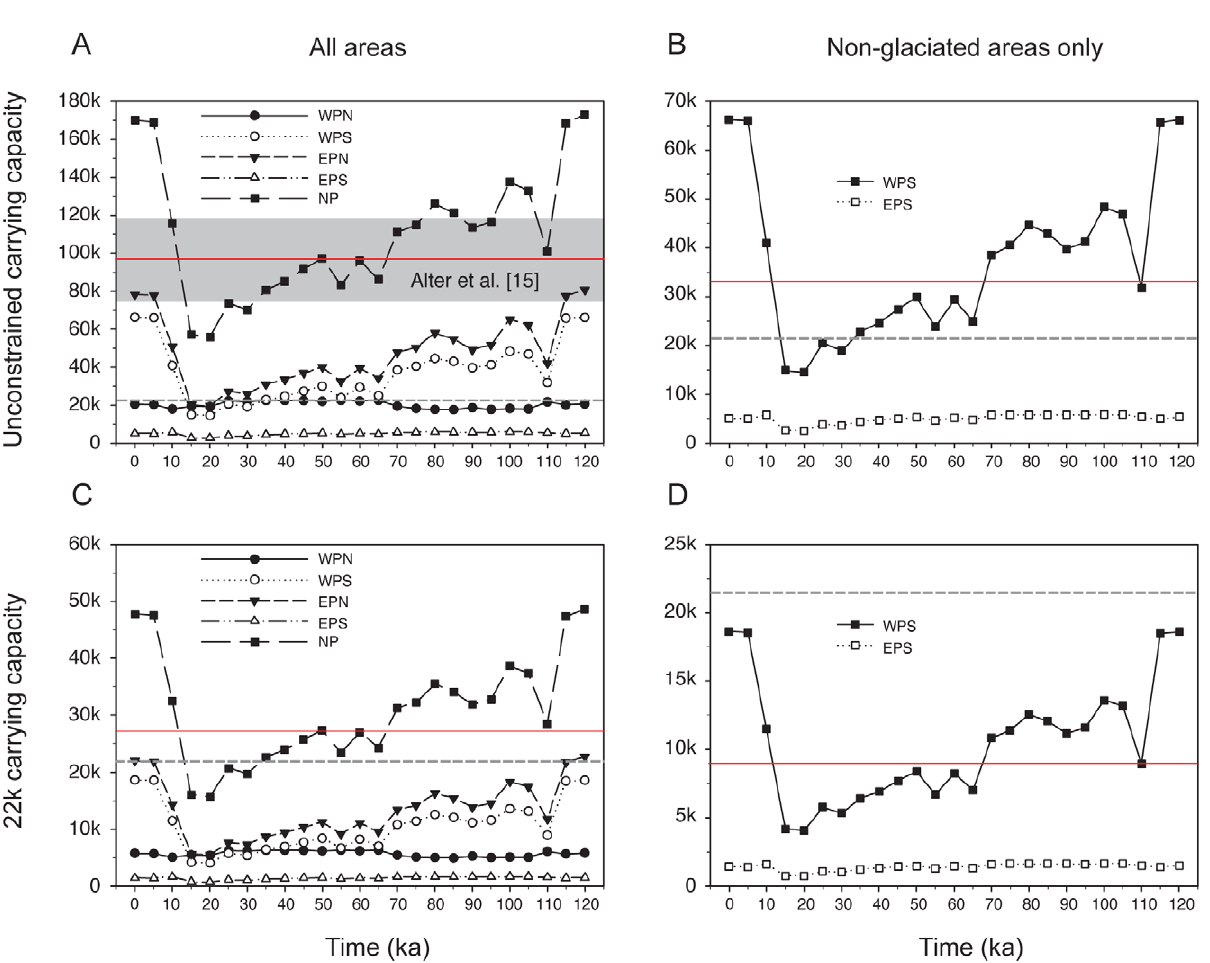
Figure 3. Estimated carrying capacity for North Pacific gray whales determined by benthos availability ( , 75 m) during the last 120 ka. Dashed gray lines indicate current gray whale population size and red lines show harmonic means for carrying capacity estimates. A) Total and regional North Pacific unconstrained carrying capacities. Gray box indicates range of population size suggested by analysis of genetic diversity [15]. B) Total and regional North Pacific carrying capacities constrained to 22 k gray whales; see Table 2; C) Unconstrained, estimated carrying capacities of non-glaciated regions in the western and eastern Pacific; D) Estimated carry capacities of non-glaciated regions in the western and eastern Pacific constrained to 22 k gray whales; see Table